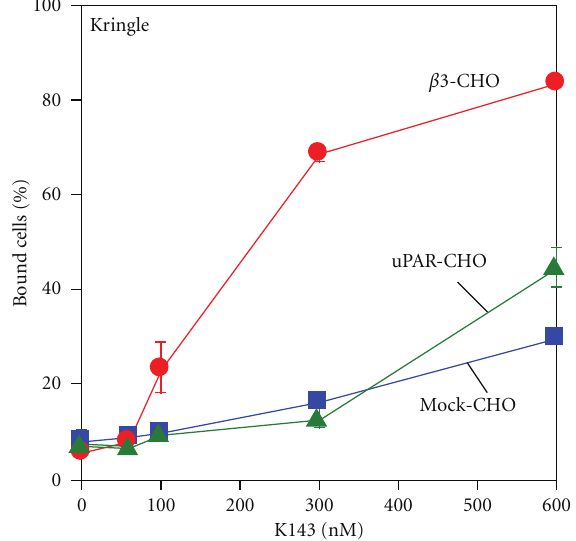
Figure 3: The kringle domain of uPA mediates binding to α v β 3. The uPA kringle domain was immobilized onto wells of 96- well microtiter plates at the indicated coating concentrations and incubated with β 3-CHO, uPAR-CHO, or mock-CHO cells. The ability of the uPA fragments to support adhesion of these cells was determined [38].